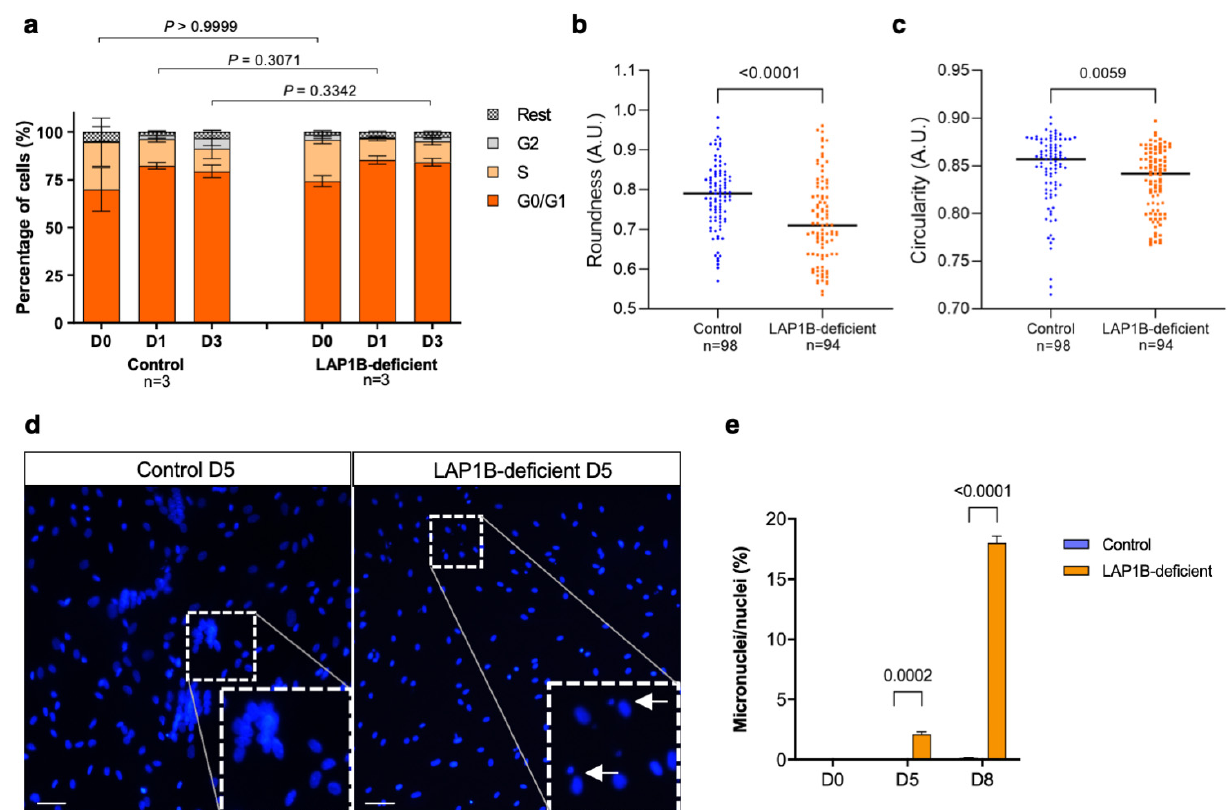
Figure 6. Cell cycle assay and nuclear morphologic and morphometric analyses. ( a ) Percentage of the control and LAP1B-deficient cells in the G0/G1, S, and G2 phases of the cell cycle, as assessed using propidium iodide staining and flow cytometry. n = 3, and p -values were determined using a two-way ANOVA followed by Bonferroni post hoc tests. ( b ) Roundness and ( c ) circularity of nuclei (A.U.; arbitrary unit) in the control and LAP1B-deficient immortalized fibroblasts. p-values were determined using the Mann–Whitney U test, and n represents the total number of nuclei evaluated in three independent experiments. ( d ) Micrographs of the control and LAP1B-deficient cells at day 5 of differentiation, which were stained using DAPI for nuclei. Arrows indicate the nuclei associated with the micronuclei. Scale bar: 20 μ m. ( e ) Percentage of micronuclei relative to the total number of nuclei in the control and LAP1B-deficient cells at days 0, 5, and 8 of differentiation. n = 3, and p -values were determined using a two-way ANOVA followed by Bonferroni post hoc tests.